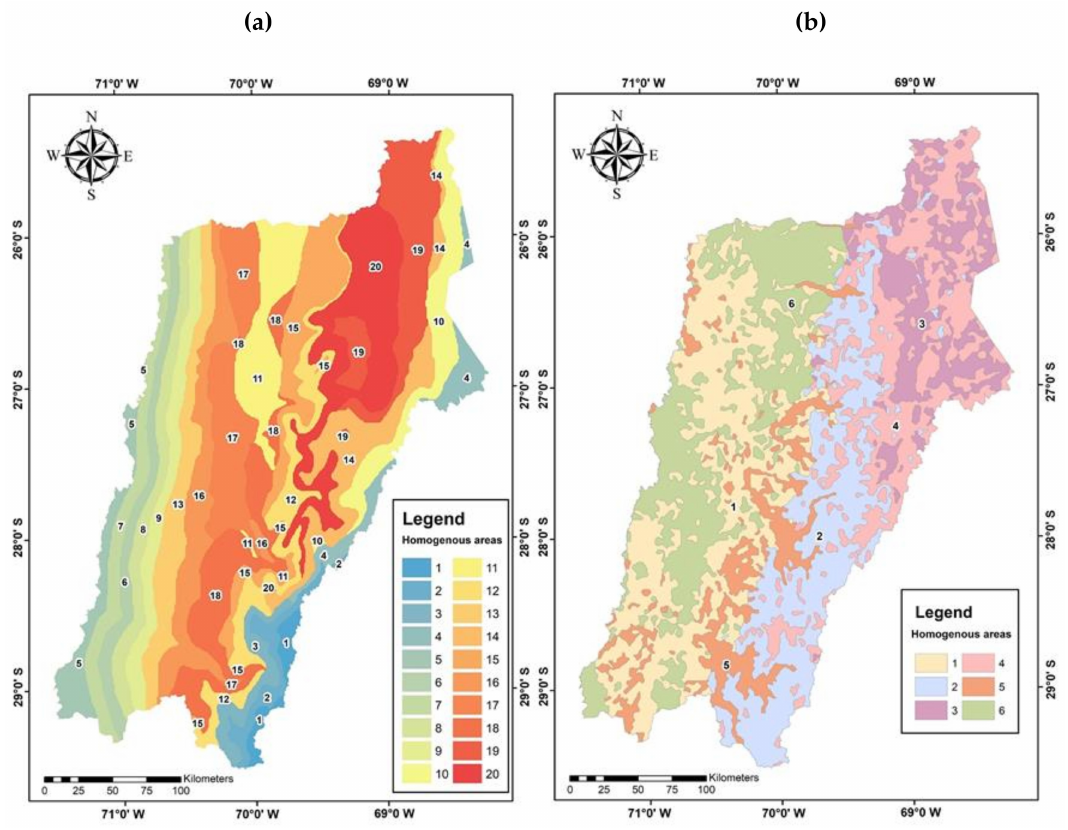
Figure 5. Zoning cartography for ( a ) climate, using 20 clusters, and ( b ) topography, using six clusters, for the Atacama region, obtained through principal component analysis (PCA) and cluster analysis